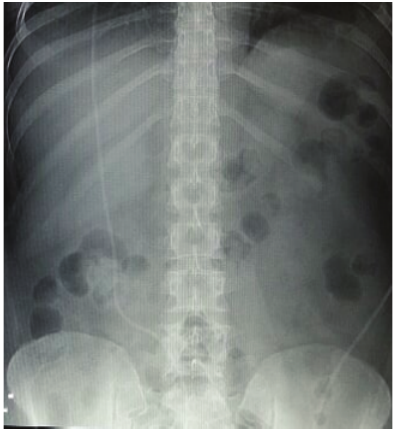
Figure 2: Supine abdominal X-ray.